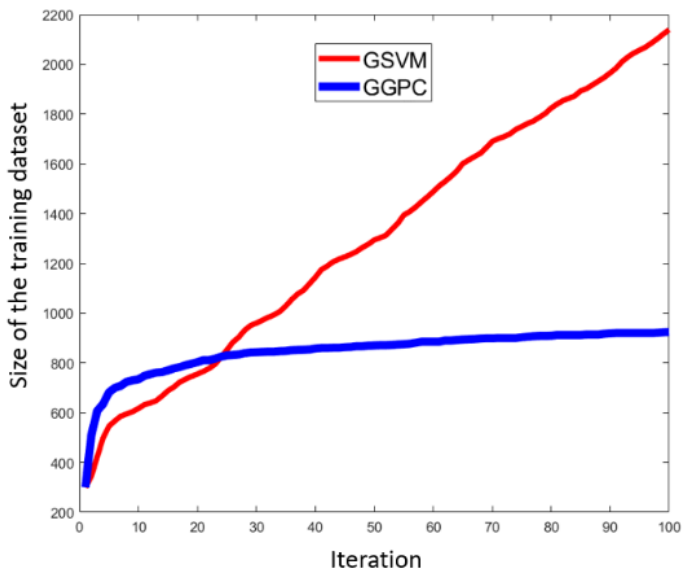
Figure 10. Size curves of training datasets for GSVM and GGPC in experiments involving car-following scenarios. The blue and red curves belong to GGPC and GSVM, respectively.